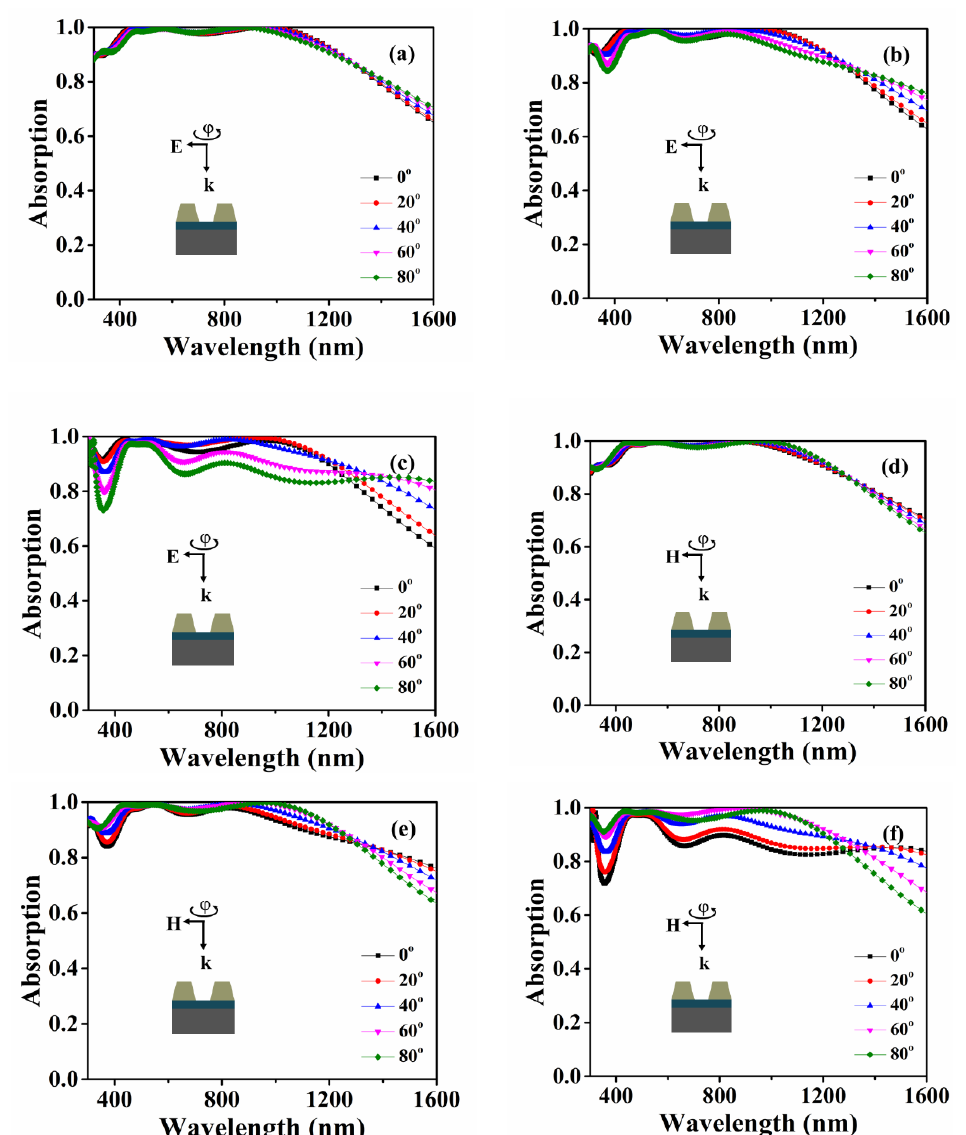
Figure 8. Absorption spectra of various polarization angles under the different oblique incidence ◦ , 30 ◦ , and 40 ◦ for TE-mode ( a )–( c ) and TM-mode ( d )–( f ), angles of 20 °, 30 °, and 40 ° for TE-mode ( a ) – ( c ) and TM-mode ( d ) – ( f ), respectively. of 20